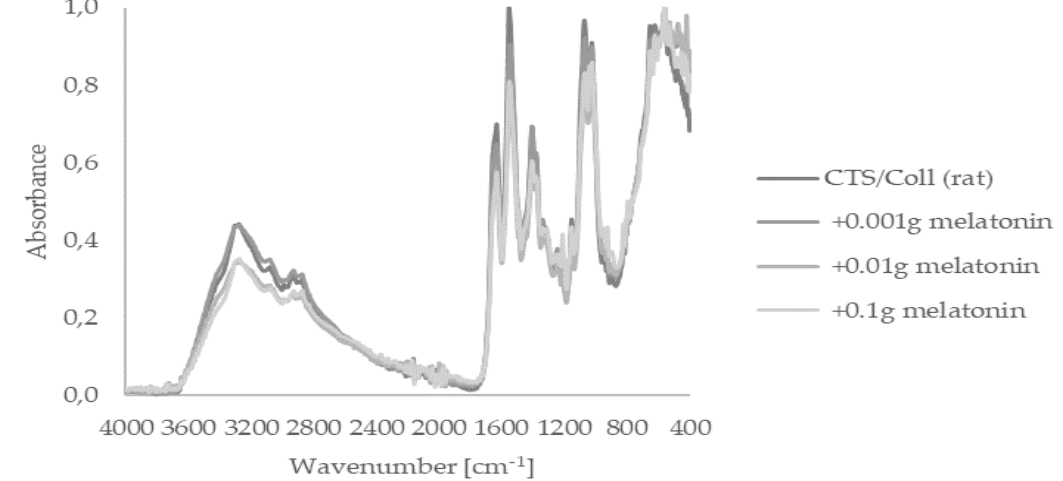
Figure 2. The FTIR-ATR spectra of scaffolds based on chitosan (CTS)/collagen (Coll) (derived from rat tail tendon) mixture with and without melatonin in a dose-dependent manner.